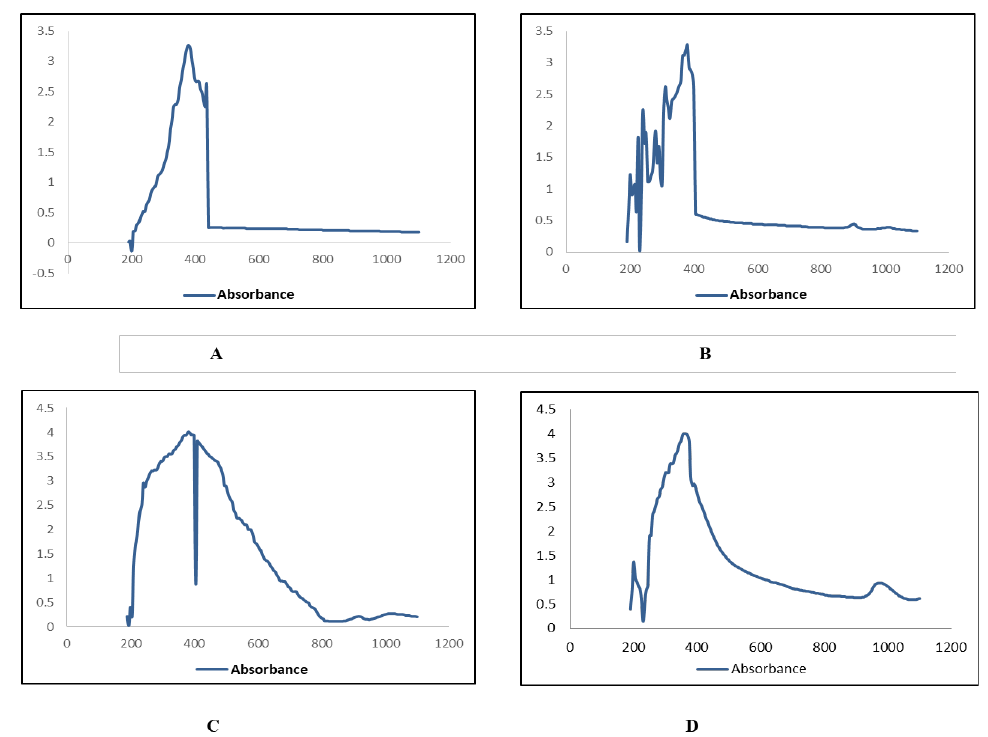
Figure 3. UV Visible absorption spectra of zinc oxide nanoparticles of roots; ( A ) n_Hexane ( B ) Ethyl Acetate ( C ) Methanol ( D ) Aqueous.